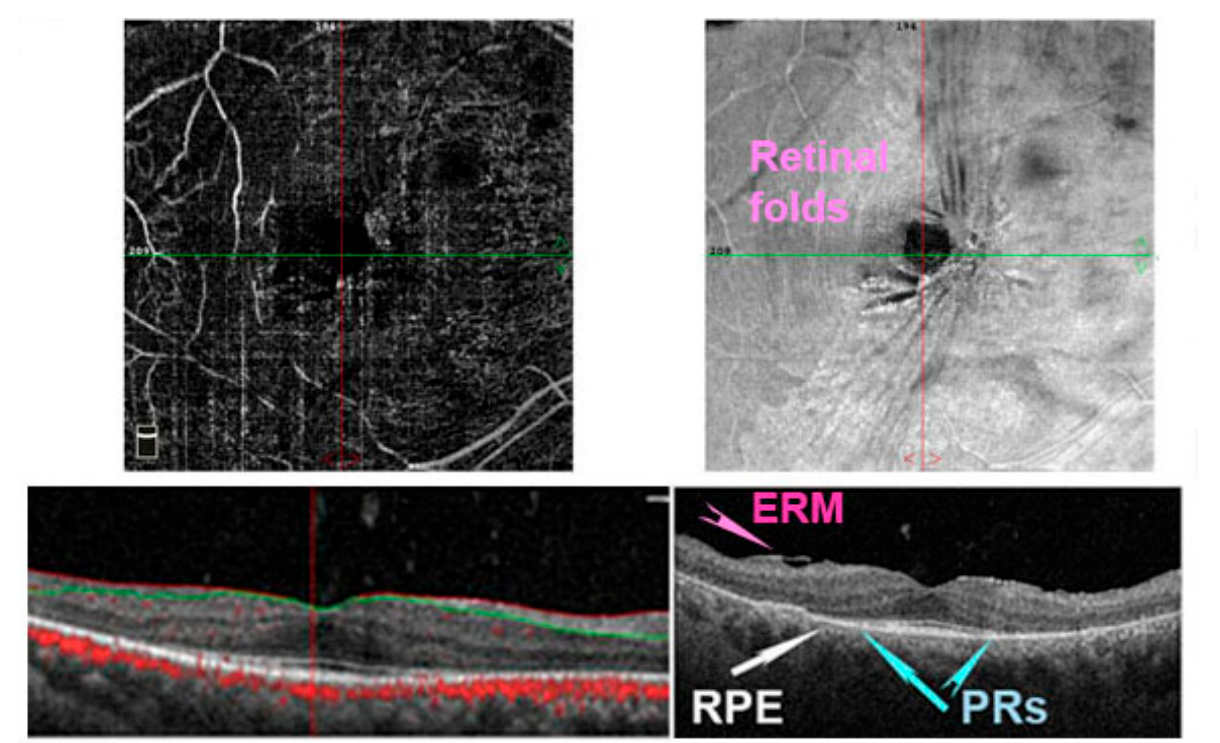
Figure 5. Optical coherence tomography angiography (OCTA) in a patient with retinitis pigmentosa (RP). In right eye, it is possible to notice the absence of photoreceptors (PRs) (blue arrows) and a retinal pigment epithelium (RPE) degeneration (white arrows) beyond the perifoveal area. The vascular plexus is reduced (upper left image). Moreover, an epiretinal membrane (ERM) is detected in the enface image (upper right image) and structural image (bottom right panel) forming some retinal folds.